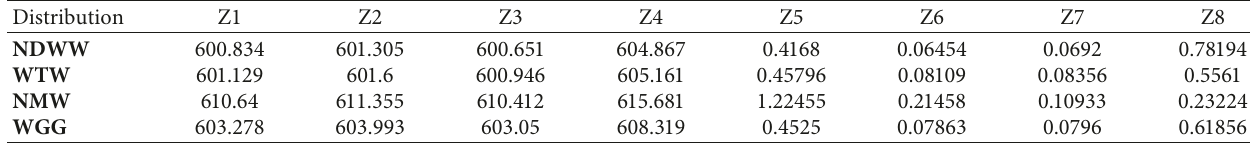
Table 11: Numerical values of Z1, Z2, Z3, Z4, Z5, Z6, Z7, and Z8 for the dataset (3)